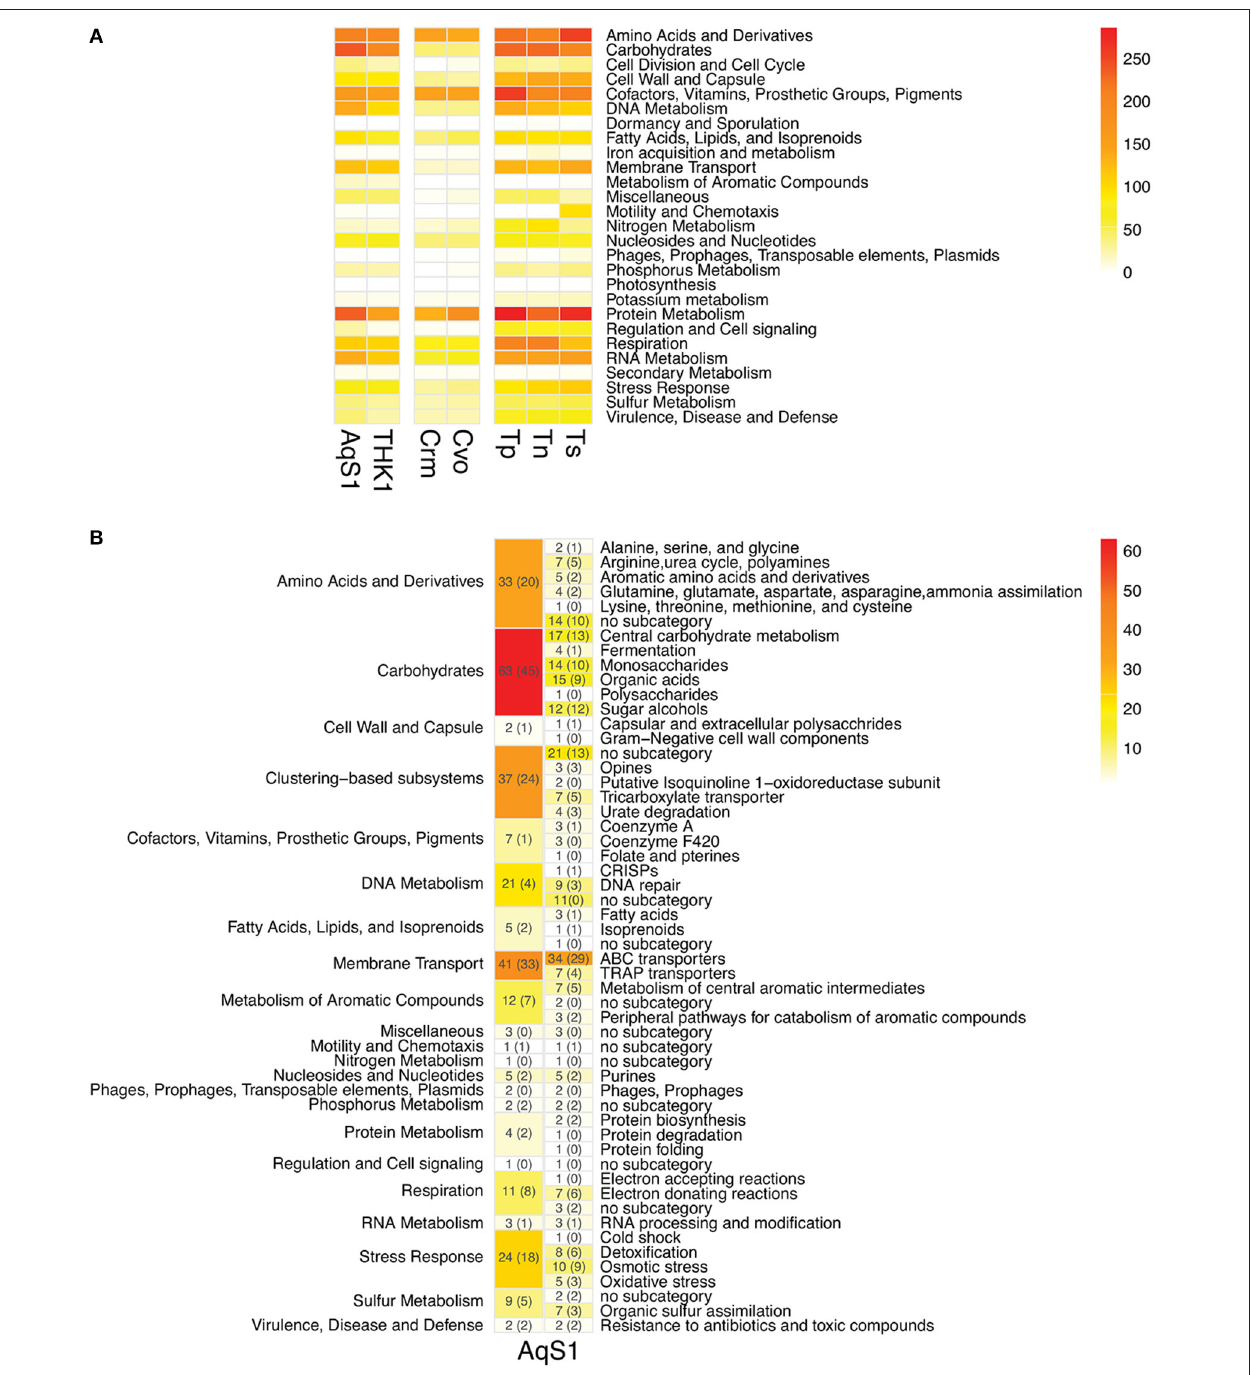
FIGURE 2 | (A) Functional comparison between AqS1 , three closest free-living and two symbiont sulfur-oxidizing strains using FIGfam-based subsystems derived from RAST annotations. THK1 Thioalkalivibrio sp. HK1 (isolated from the sponge Haliclona cymaeformis) ; Crm Candidatus Ruthia magnifica (isolated from the clam